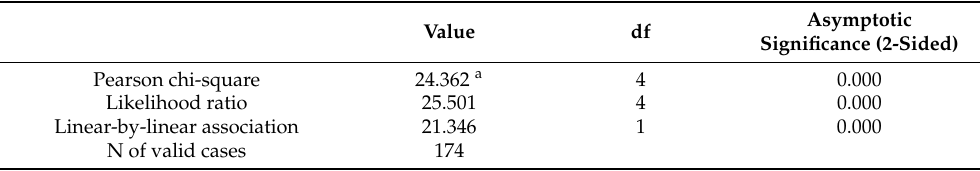
Table 4. Chi-square tests for the elements that meet the expectations with online communication in relationships with colleagues (e.g., Microsoft Teams, Skype, etc.). Value df Figure 4. The satisfaction/dissatisfaction degree in the online communication with colleagues (e.g., Microsoft Teams, Skype, etc.). Source: Data from field quizzes, 2021, 2022.